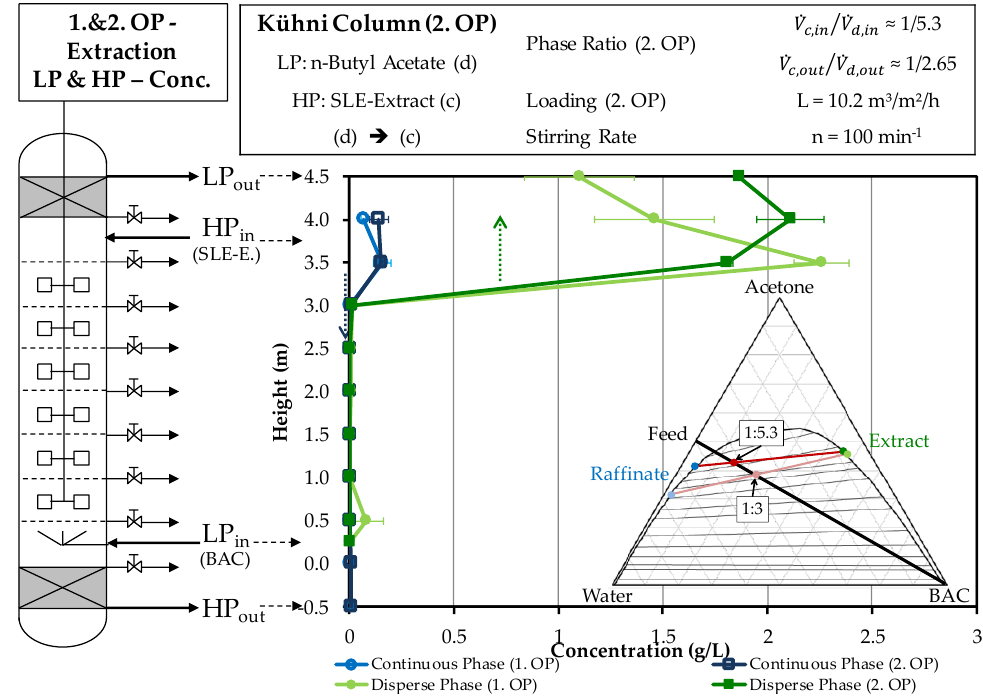
Figure 7. Comparison of the concentration profiles of artemisinin across the column height of the light and heavy phase in the experimental progression of the first and second operating points of extraction obtained by HPLC. OP (operating point), BAC (butyl acetate), Conc. (concentration). Processes 2018 , 6 , 179; doi:10.3390/pr6100179